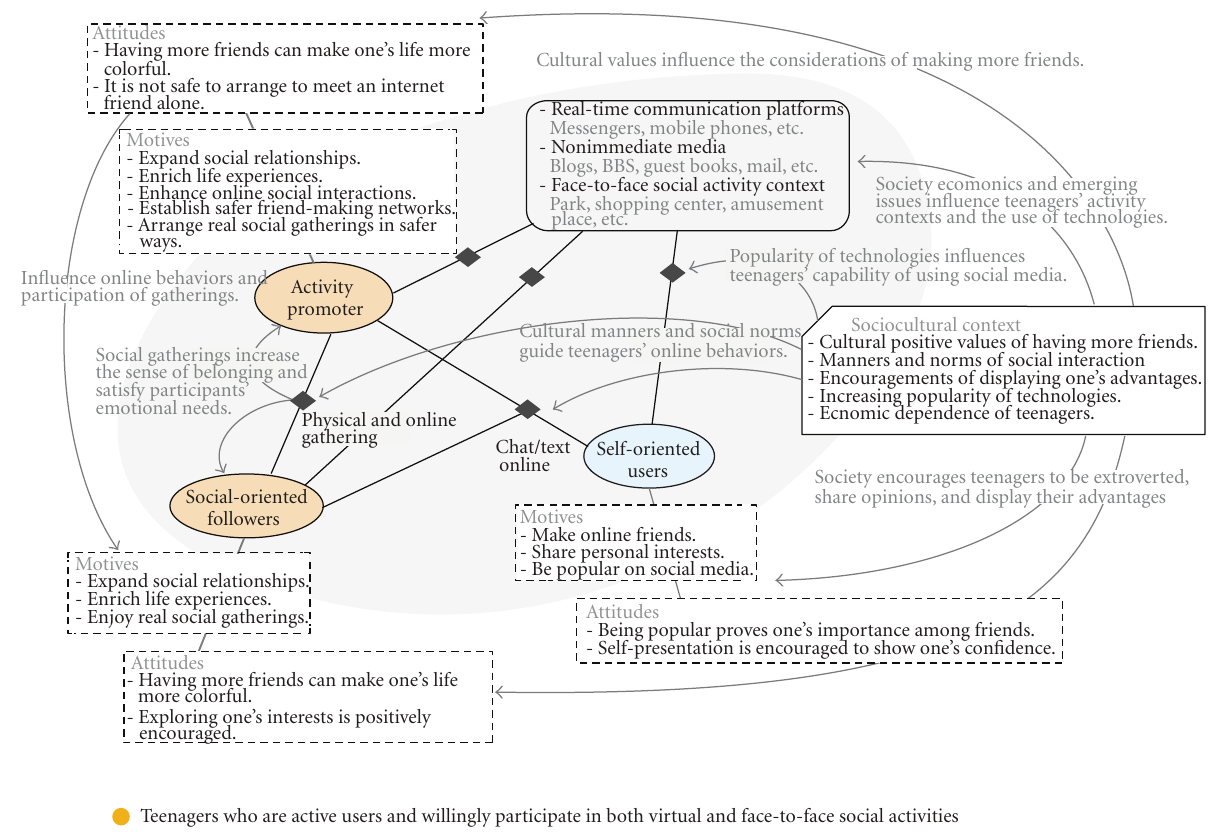
Figure 2: Diverse user types of social